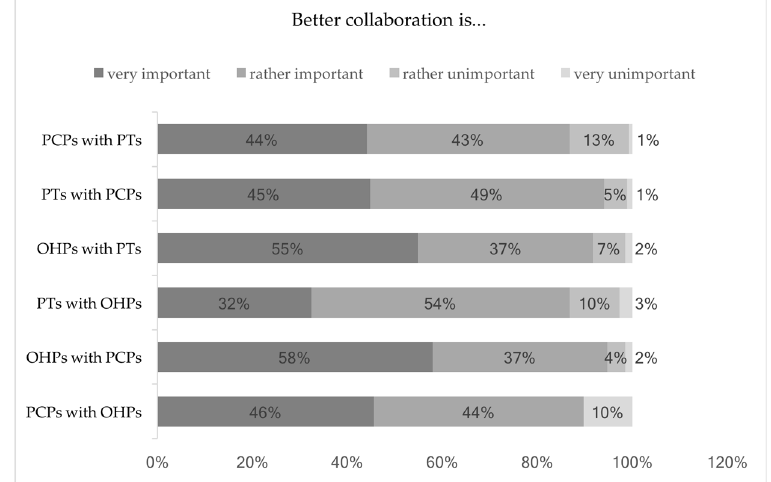
Figure 2. Importance of a better collaboration for the prevention of common mental